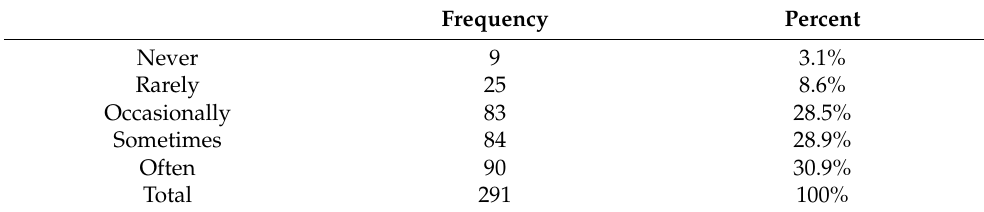
Table 5. Frequency of health-related